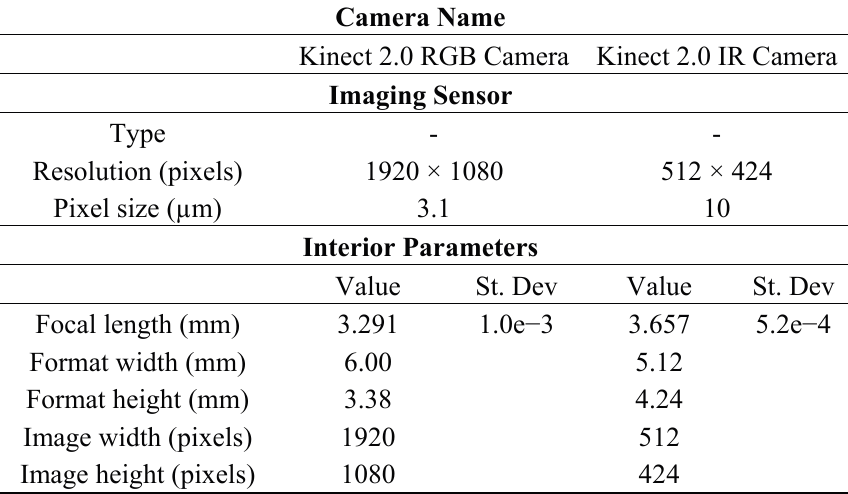
Table 3. Sensors and IO parameters of RGB and IR cameras estimated during the camera calibration procedure for Kinect